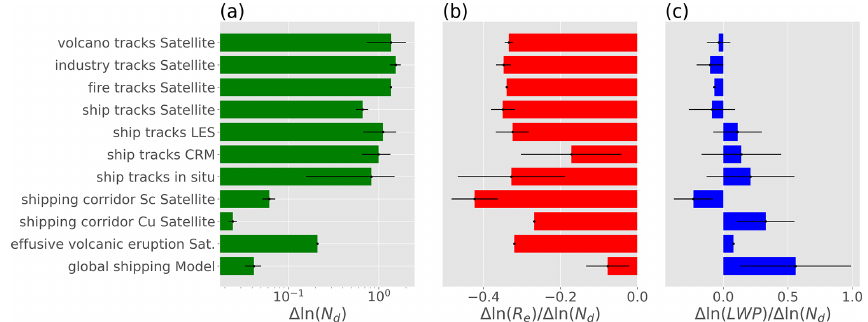
Figure 10. Change in (a) cloud droplet concentration (cid:49)N d , (b) sensitivity of cloud droplet effective radius change to N d , and (c) sensitivity of liquid water path change (LWP) to N d averaged over numerous studies involving experiments of opportunity. The number of studies going into each category are as follows: volcano tracks Satellite (6), industry tracks Satellite (9), fire tracks Satellite (1), ship tracks Satellite (9), ship tracks LES (6), ship tracks CRM (4), ship tracks in situ (18), shipping corridor Sc Satellite (2), shipping corridor Cu Satellite (2), effusive volcanic eruption Sat. (1), and global shipping Model (3). For a complete listing see Table S1. Error bars represent 1 standard deviation of reported values for each category representing diversity of the mean amongst